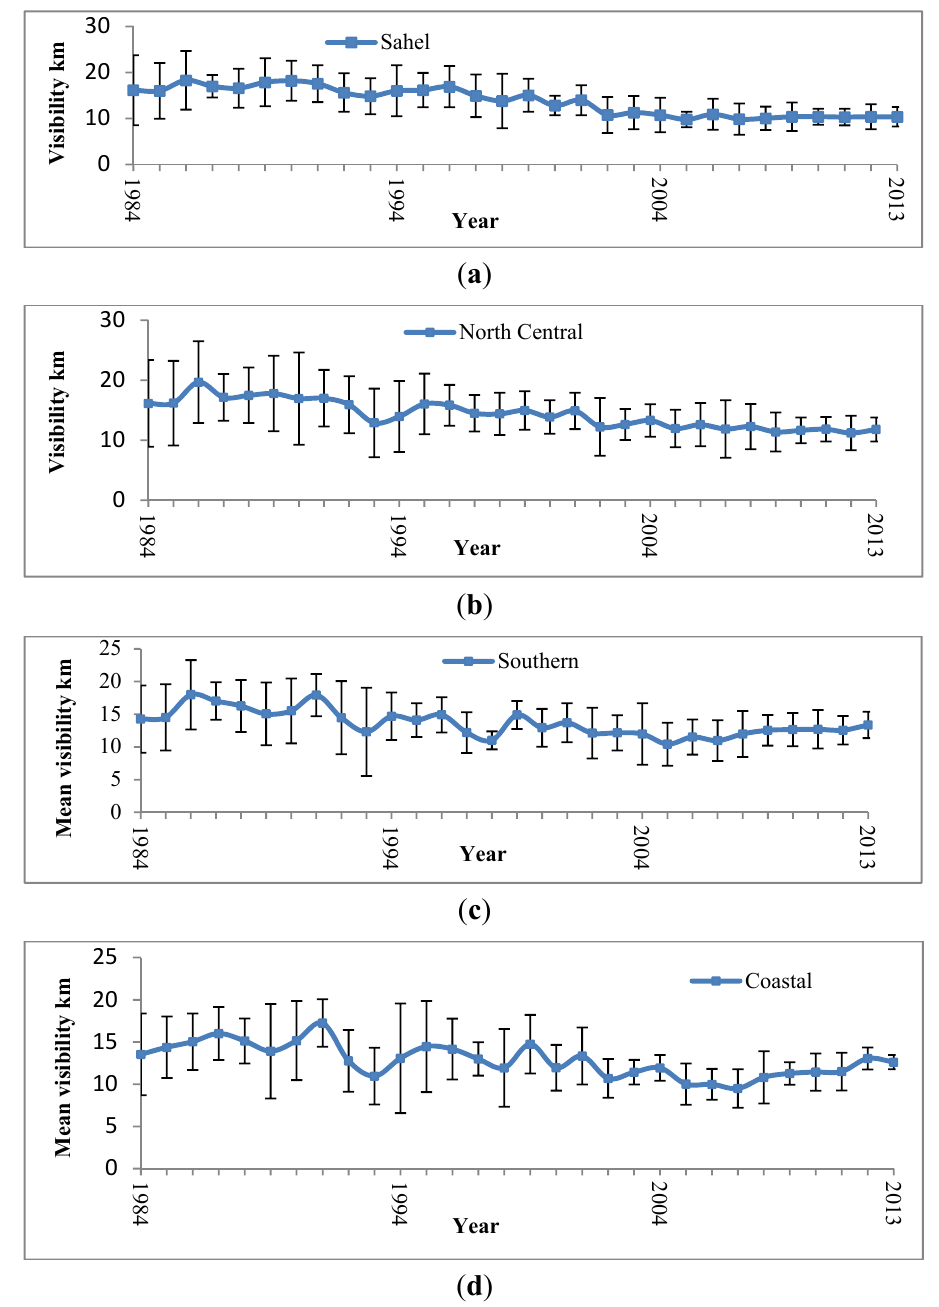
Figure 5. The 30 years Annual mean visibility trend over Nigerian zones at four climatic zones of Nigeria: ( a ) sahel, ( b ) North central, ( c ) southern, ( d ) coastal